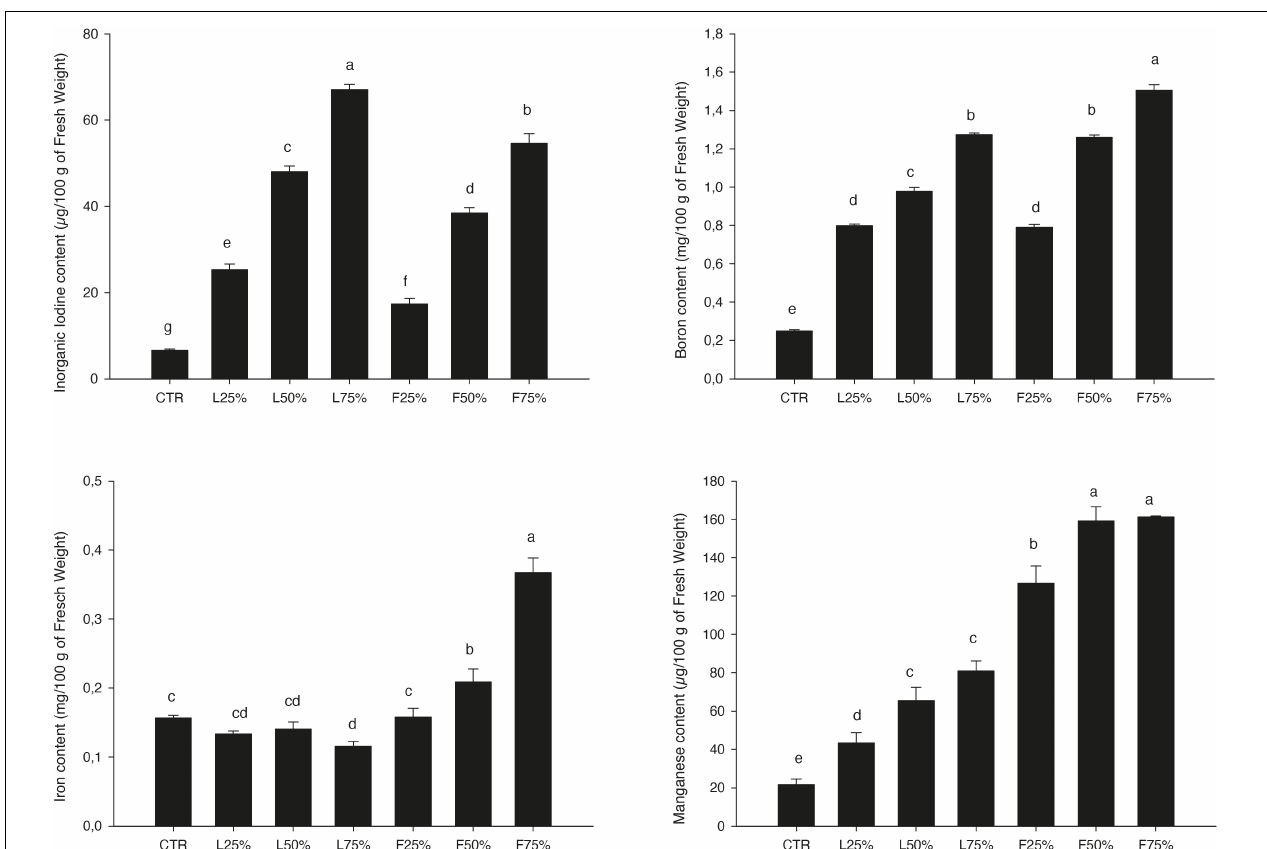
FIGURE 2 | Inorganic iodine, Boron, Iron, and Manganese content in the Brassica rapa L. Mizuna as effected by Posidonia oceanica (L.) Delile (PO) leaves (L) and fibers (F) in the growing media. CTR (control 100% peat), L 25% (75% peat and 25% PO L), L 50% (50% peat and 50% PO L), L 75% (25% peat and 75% PO L), F 25%